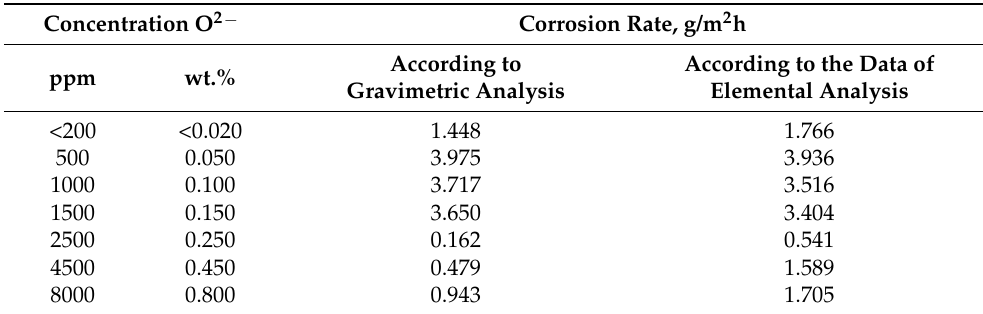
Table 2. Corrosion rate of 12Cr18Ni10Ti steel samples aged in FLiNaK melt at different concentrations of Li 2 O.